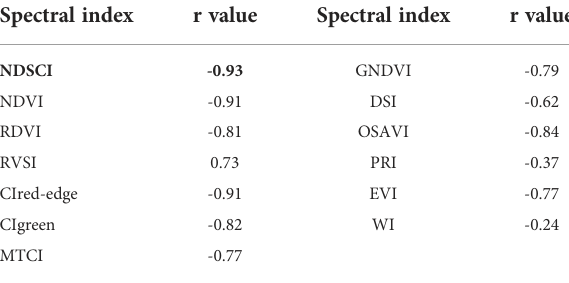
TABLE 4 Correlation coef fi cient (r) values between different spectral indices and disease